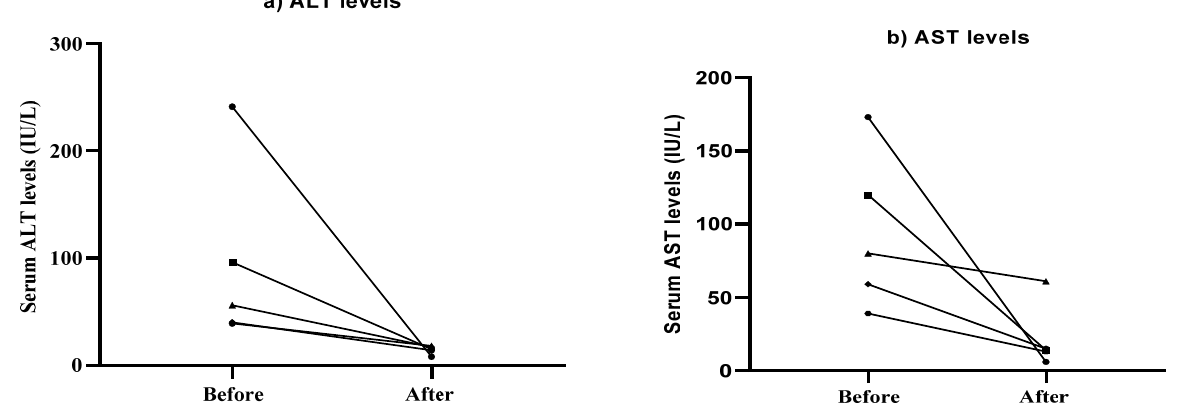
Figure 3. Alterations in serum ALT ( a ) and AST ( b ) levels in patients following 12 weeks of treatment with trehalose.